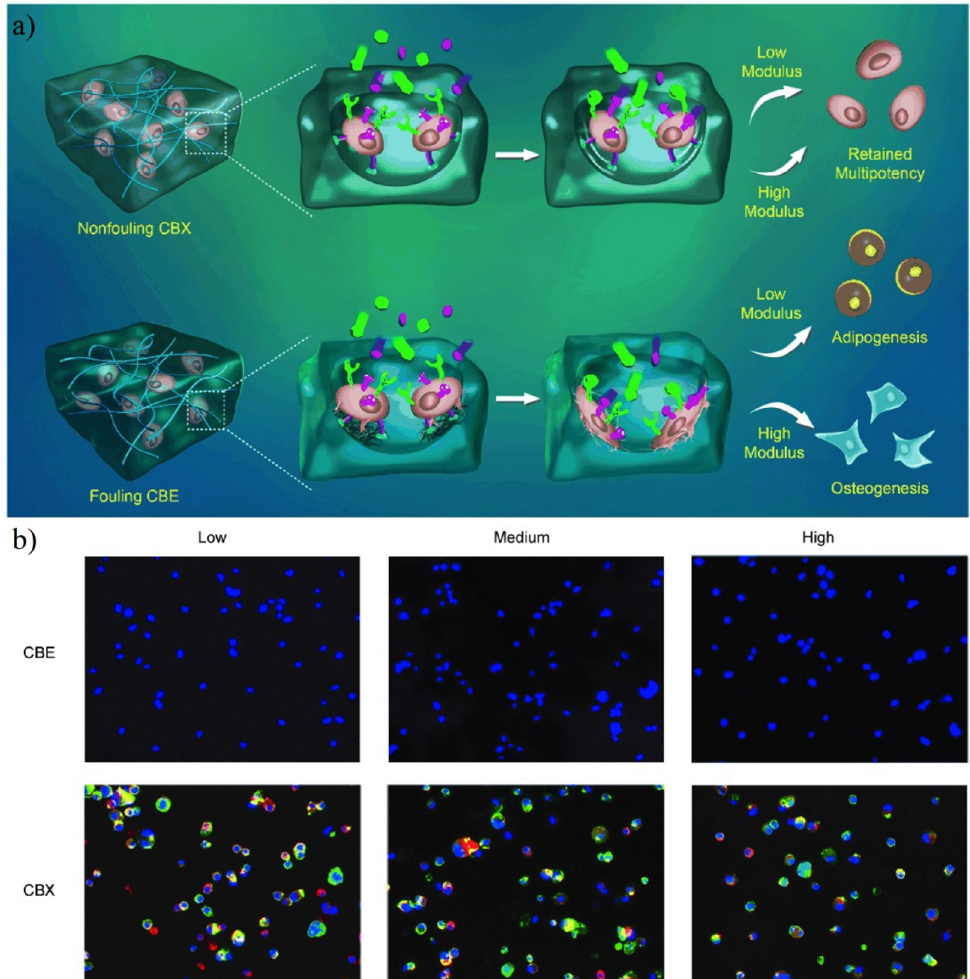
Figure 19. Fate choice of hMSCs in antifouling PCBAA hydrogel with zwitterionic crosslinker (named as CBX) and non-ionic crosslinker (named as CBE). ( a ) Schematic illustration of the behavior of hMSCs in CBX and CBE. cRGD moieties are denoted as cyan hemispheres, and differentiation factors are denoted as colored particles. ( b ) Immunofluorescence staining of hMSCs by undifferentiated-cell markers ALCAM (green) and STRO-1 (red; nuclei: blue) in CBX and CBE. Most of the hMSCs in hydrogel CBE were not able to express this biomarker. Reproduced with permission from [159] . Copyright 2014 WILEY-VCH Verlag GmbH & Co. KGaA, Weinheim.